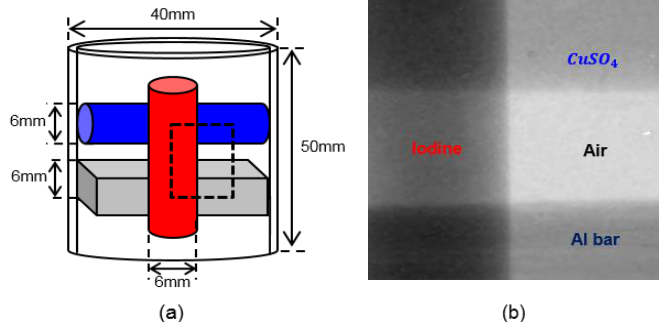
Figure 6. The derived mapping function between the photon energy and the threshold DAC.